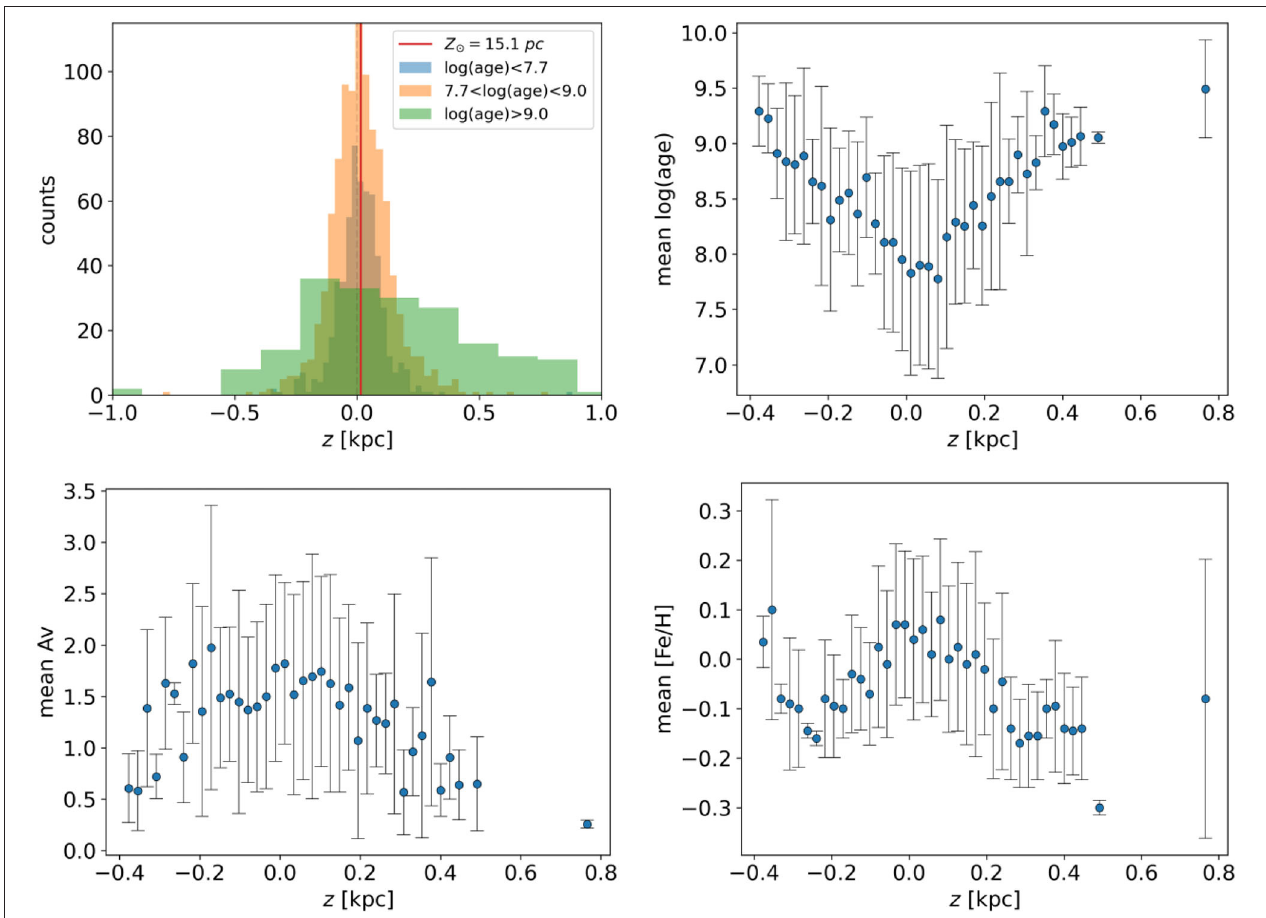
FIGURE 5 | Distribution of the open clusters and their parameters as a function of height relative to the plane of the Galaxy.The upper left panel shows histograms of the distances of the clusters to the Galactic plane in different colors for three ranges of ages. Note that the brown color is the result of superposing blue and orange colors. The other panels are clearly showing the expected trends in age, extinction, and metallicity, as a function of distance to the Galactic